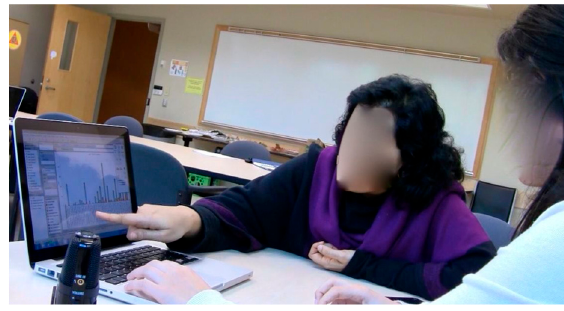
Figure 6. Thinking with the tool. Table 1. SMEs rating their interactions with the tool.